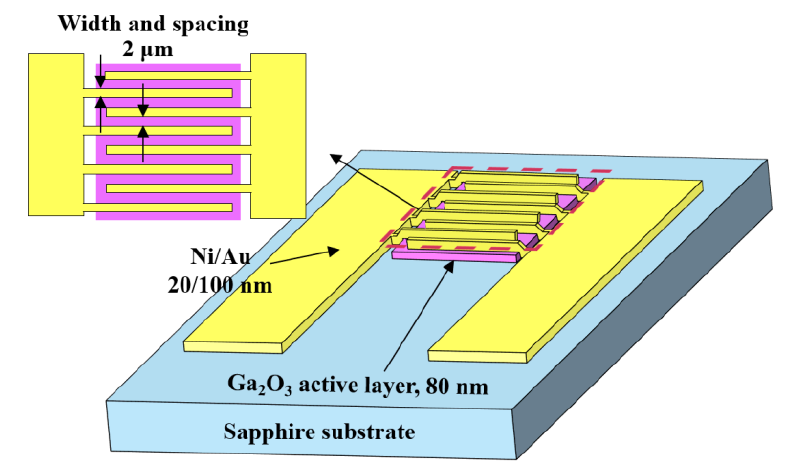
Figure 1. Schematic configuration of metal-semiconductor-metal ultraviolet C photodetectors.